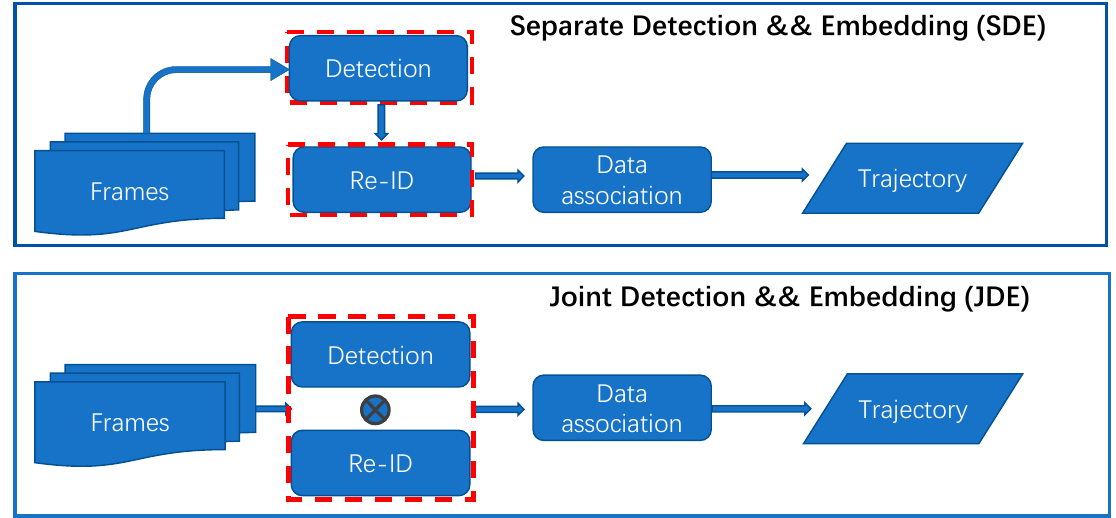
Figure 1. Overview of MOT algorithms with the separate detection and embedding (SDE) paradigm and the joint detection and embedding (JDE) paradigm.